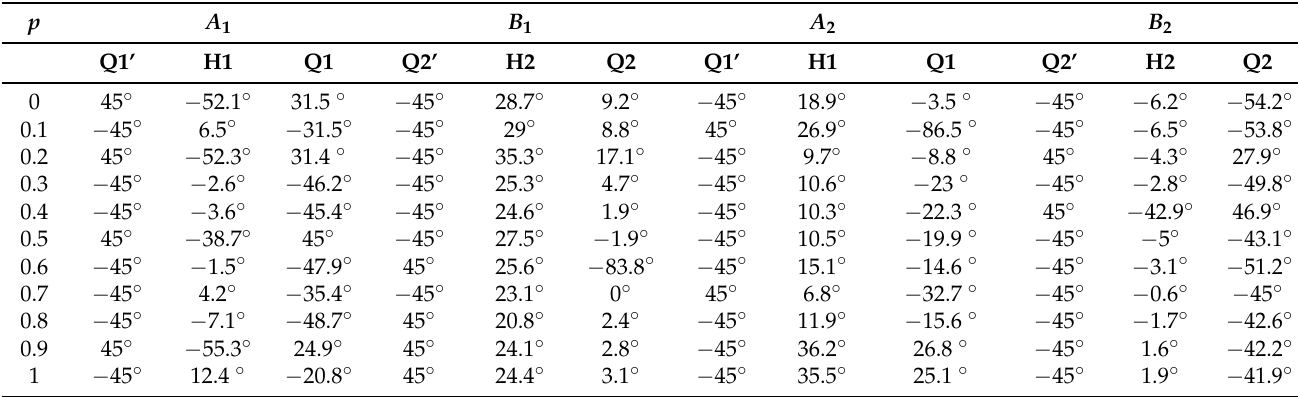
Table 1. The different setting angles of the sandwich type QWP-HWP-QWP sequence to realize the measurement operators in demonstration of the CFFW